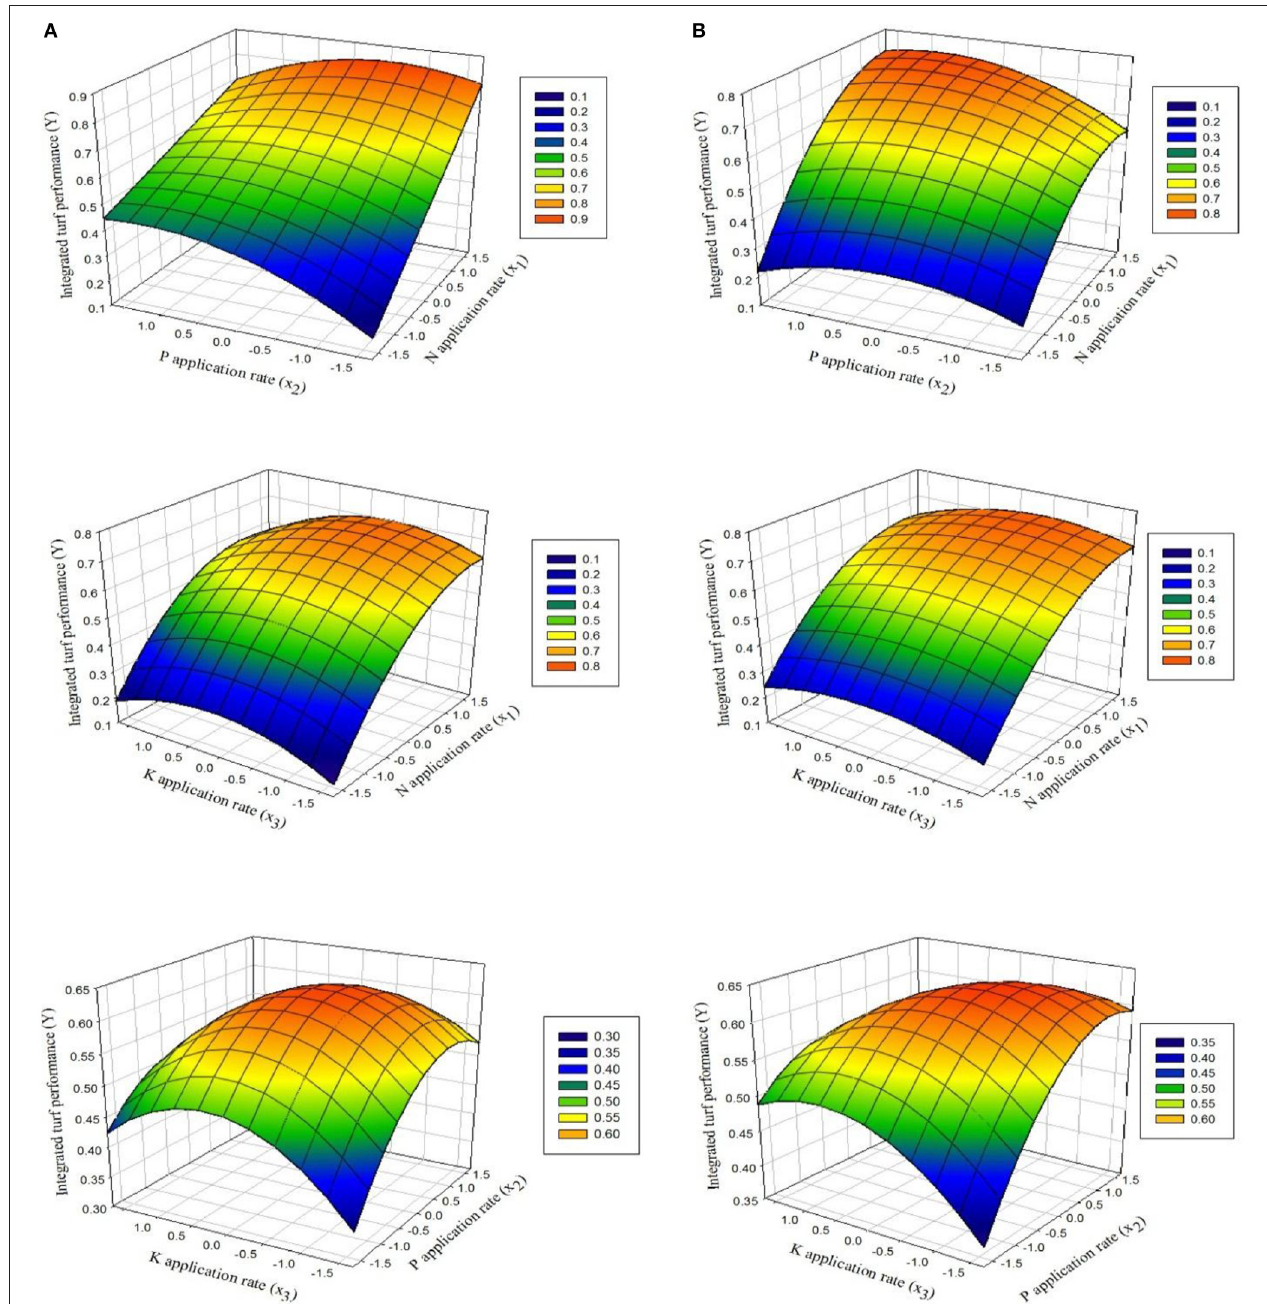
FIGURE 2 | Response surfaces showing the effects of fertilization with N and P, N and K, and P and K on ITP for overseeded perennial ryegrass in (A) the first experiment and (B) the second